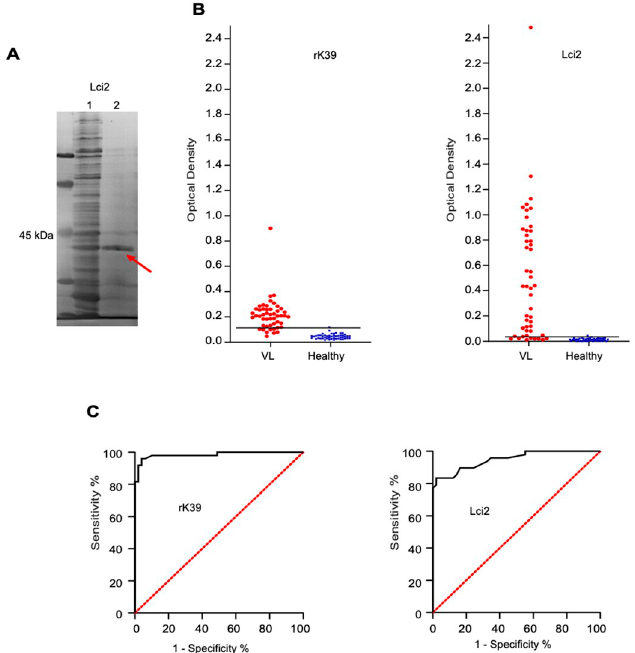
Fig 1. Serological evaluation of the rK39 and Lci2 recombinant antigens with sera from Visceral Leishmaniasis positive samples. (A) Polyacrylamide gel electrophoresis showing the Lci2 antigen evaluated in this study. (B) ELISA comparing the recognition of the rK39 and Lci2 recombinant proteins by human sera from VL afflicted and control individuals. (C) Corresponding ROC curves.